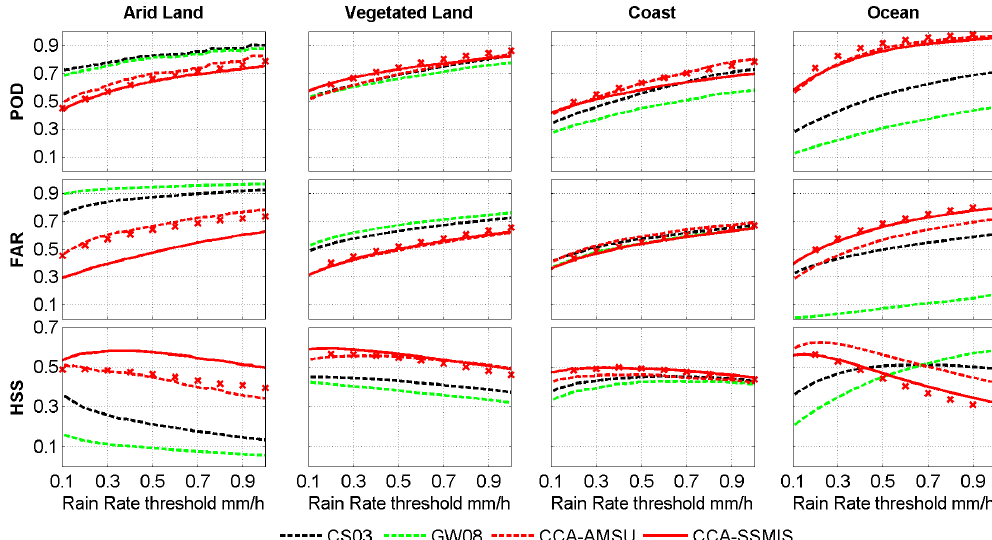
Figure 4. Same as Fig. 3 but for the AMSU/MHS data set. The CCA-SSMIS (red solid curve) (results of the CCA algorithm applied to SSMIS test data set shown in Fig. 3) are shown here for comparison. Red crosses are the result of the application of the CCA-AMSU algorithm to the training data set (years